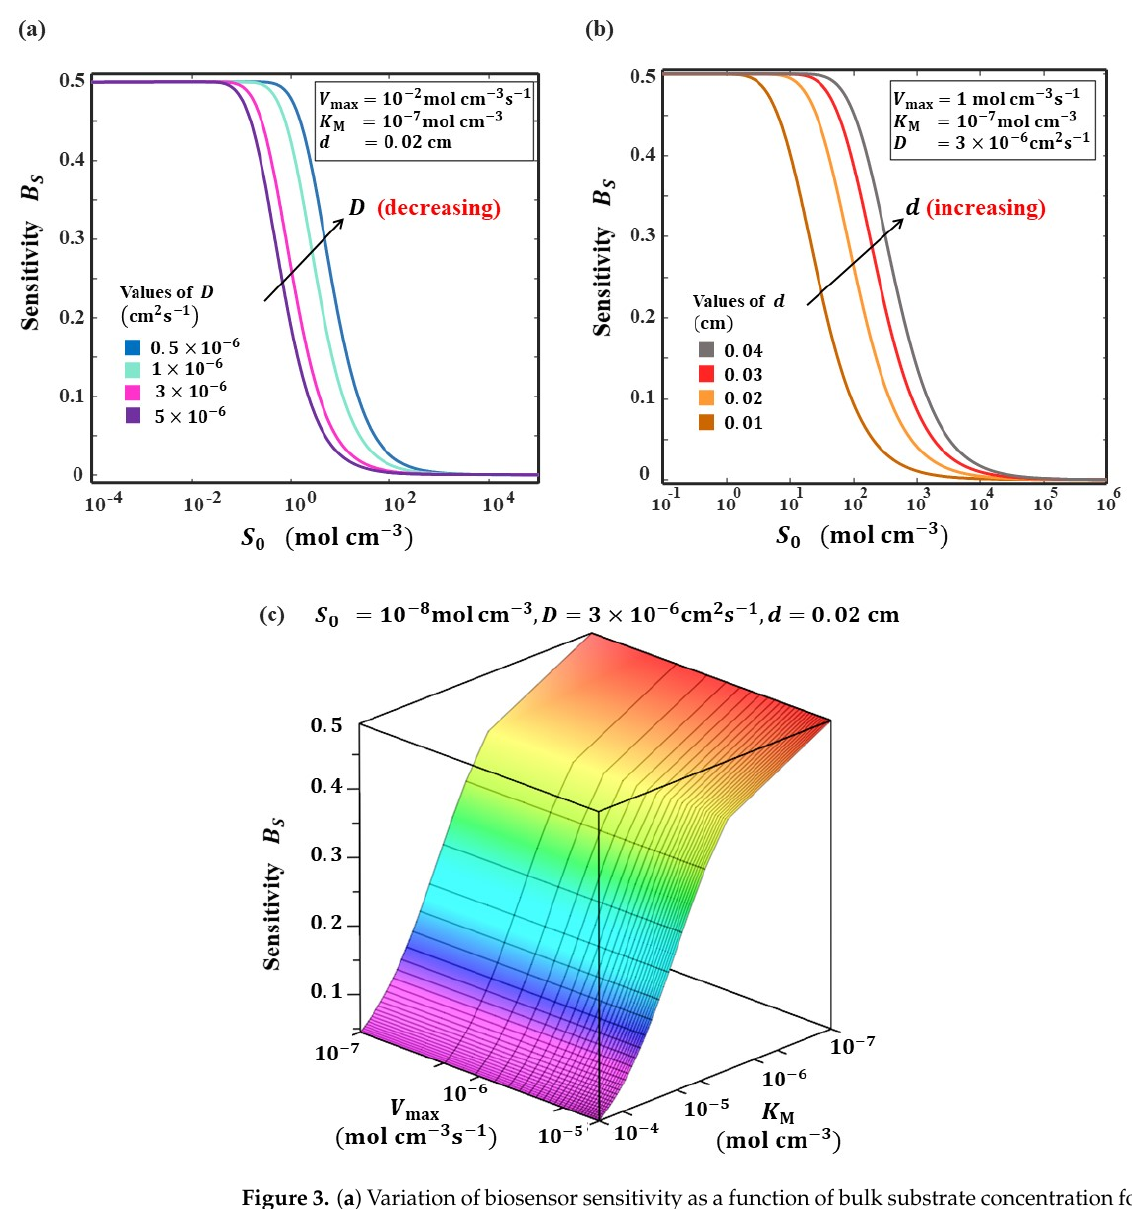
Figure 3. ( a ) Variation of biosensor sensitivity as a function of bulk substrate concentration for various values of diffusion coefficient. ( b ) Variation of biosensor sensitivity with substrate concentration for different values of enzyme layer thickness. ( c ) Three-dimensional representation of the variation of biosensor sensitivity with both maximum enzymatic reaction rate and Michaelis constant value.